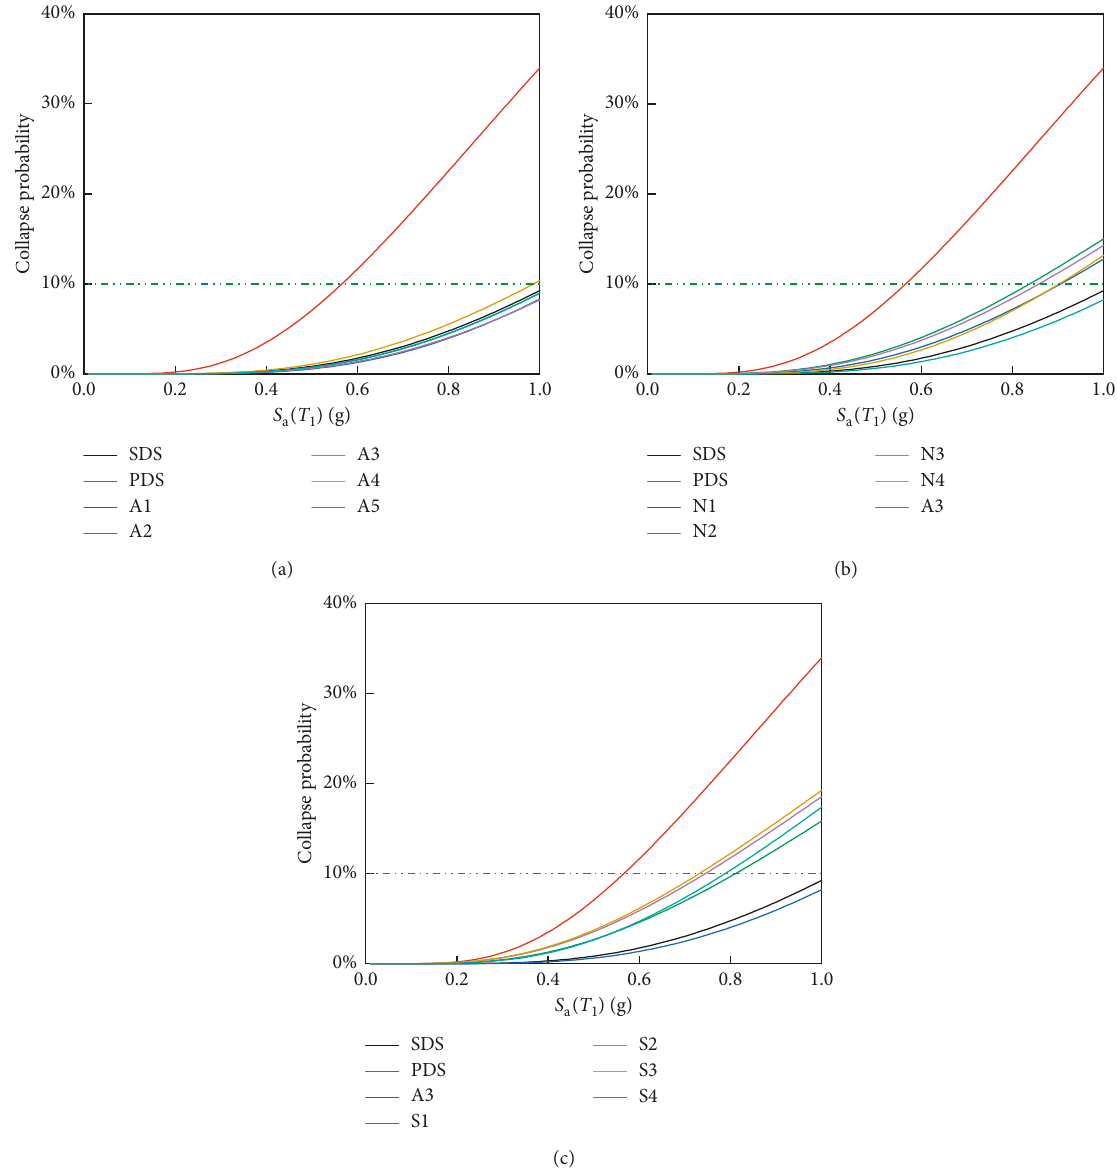
Figure 7: Collapse fragility